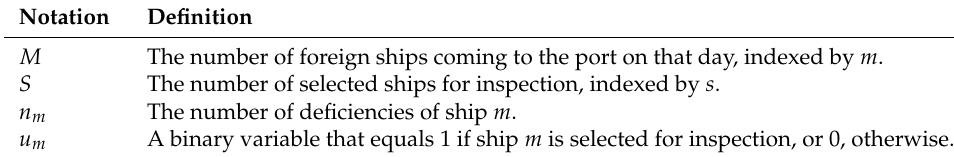
Table 1. Notation in the ship selection